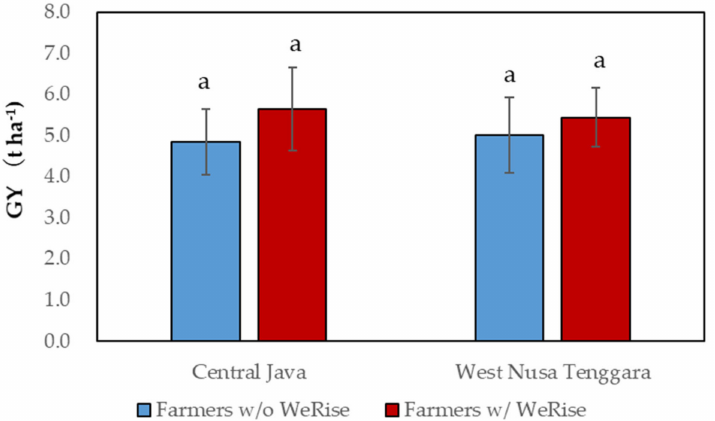
Figure 7. On-farm field validation of WeRise predictability for grain yield (GY) in Central Java and West Nusa Tenggara, Indonesia. Means with the same letter are not significantly different at 5% by Tukey’s